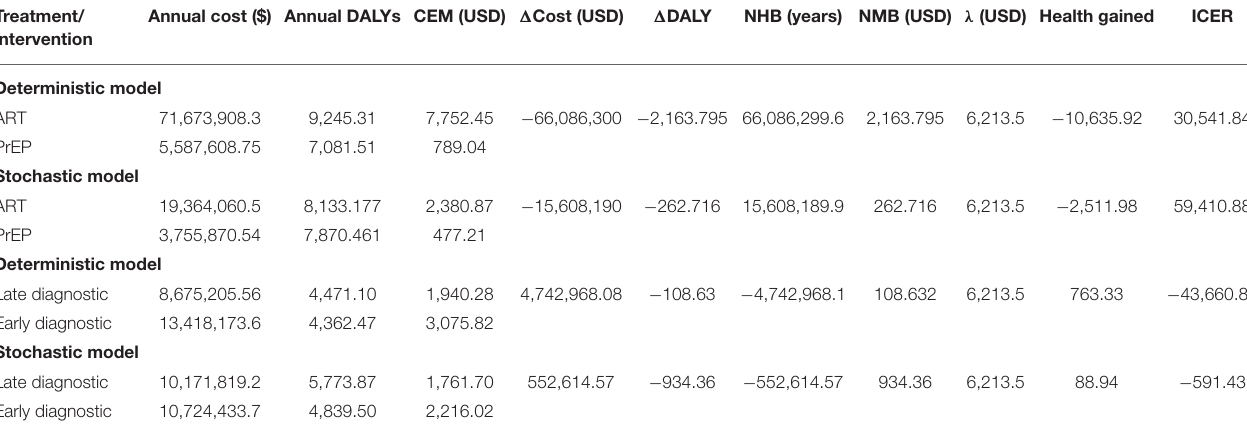
TABLE 1 | CUA results with deterministic and stochastic models applied to the different scenarios (early diagnosis and ART/PrEP) scenarios. Treatment/